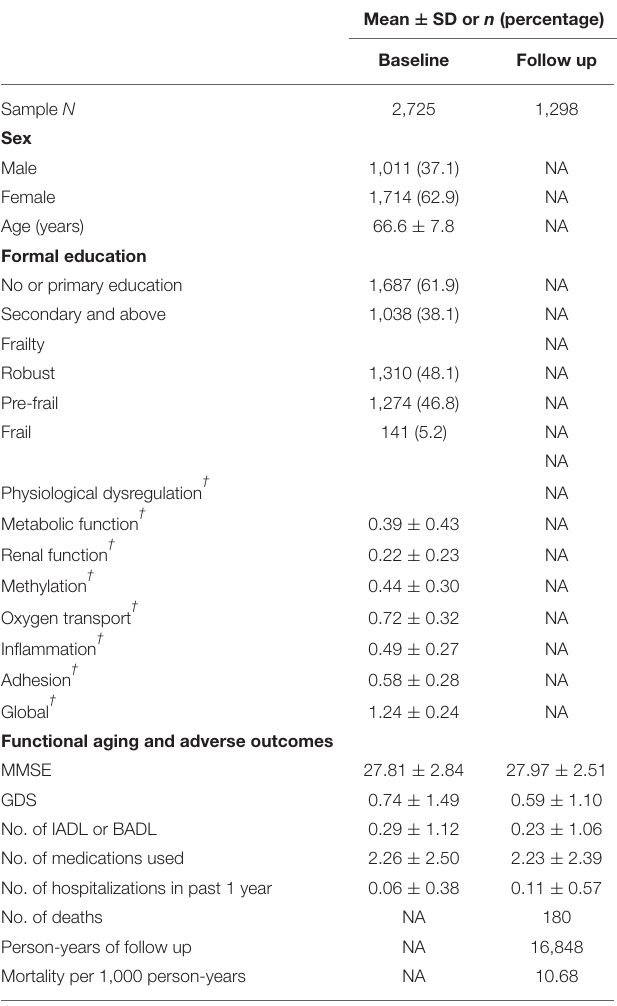
( Z = 3.233, p = 0.001) ( Table 3) . Using receiver operating TABLE 1 | Baseline demographic, frailty, and physiological dysregulation profile of study participants ( n = 2,725). characteristic (ROC) analysis to assess the predictive accuracy of PD and physical frailty for mortality, each of them showed similar Mean ± SD or n (percentage)